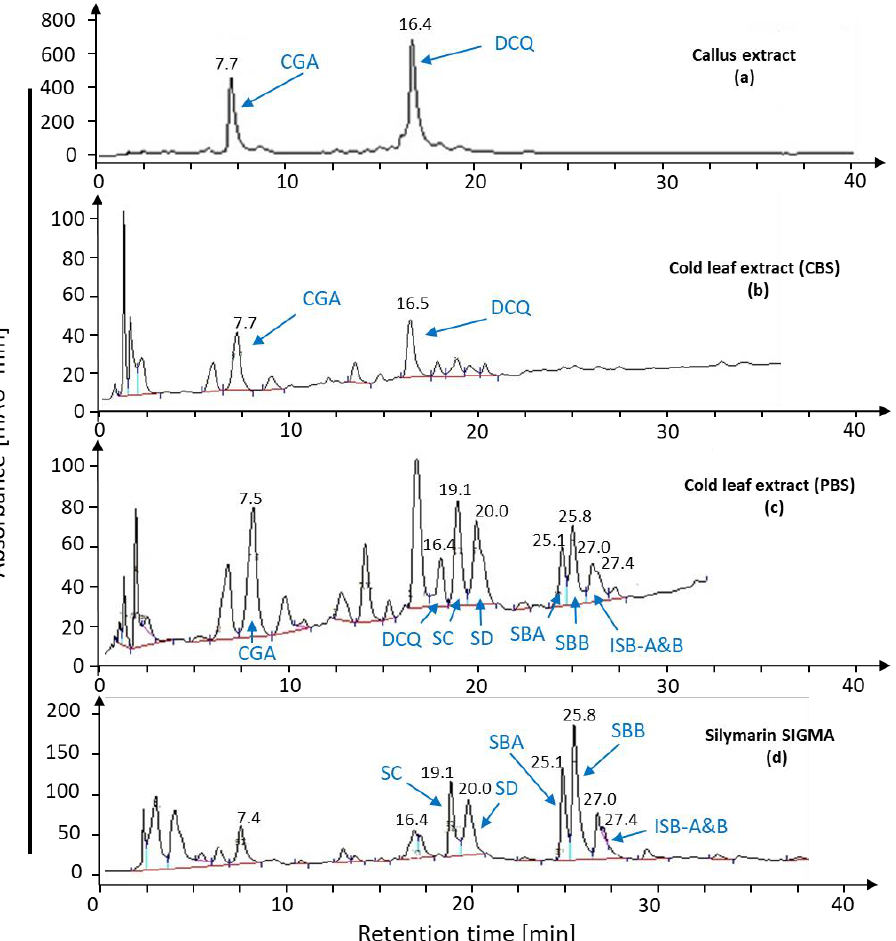
Figure 6. Bioconversion with cold leaf extract. Leaf extract obtained with either phosphate-buffered solution at pH 7.2 or citric acid buffer at pH 4.6 was incubated with callus extract and analyzed for silymarin biosynthesis after incubation for 3 h.